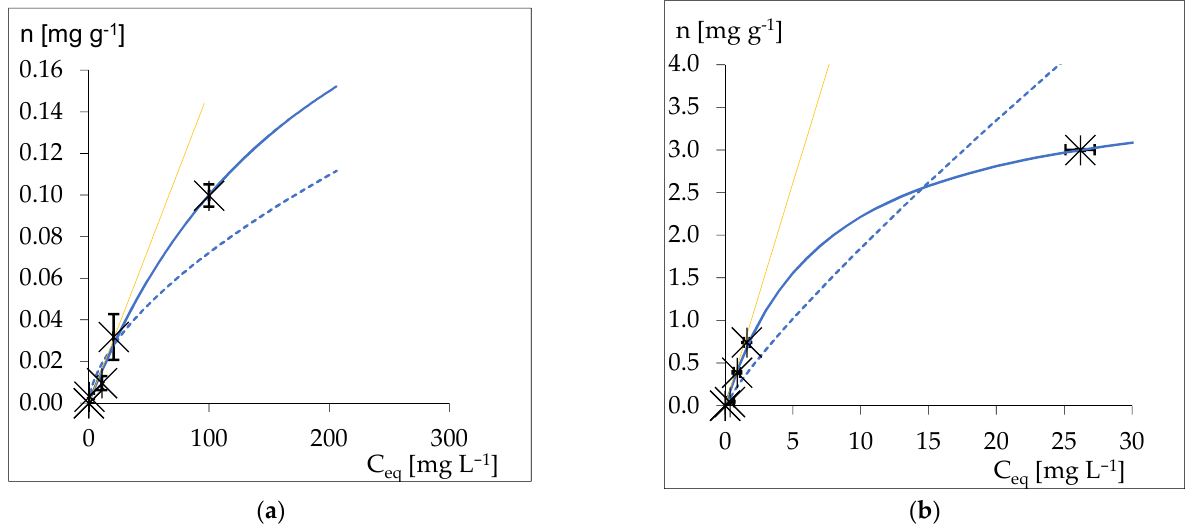
Figure 4. Sorption of the ( a ) plaque-staining agent (the spectroscopic equivalent to Brilliant Blue solutions) and ( b ) Brilliant Blue FCF (CAS: 3844-45-9) on the powdered adhesive material used in this study. The blue lines represent the Langmuir (solid line) and the Freundlich (dotted line) sorption models’ fit. The yellow line represents the affinity of the adsorbate to the adsorbent.